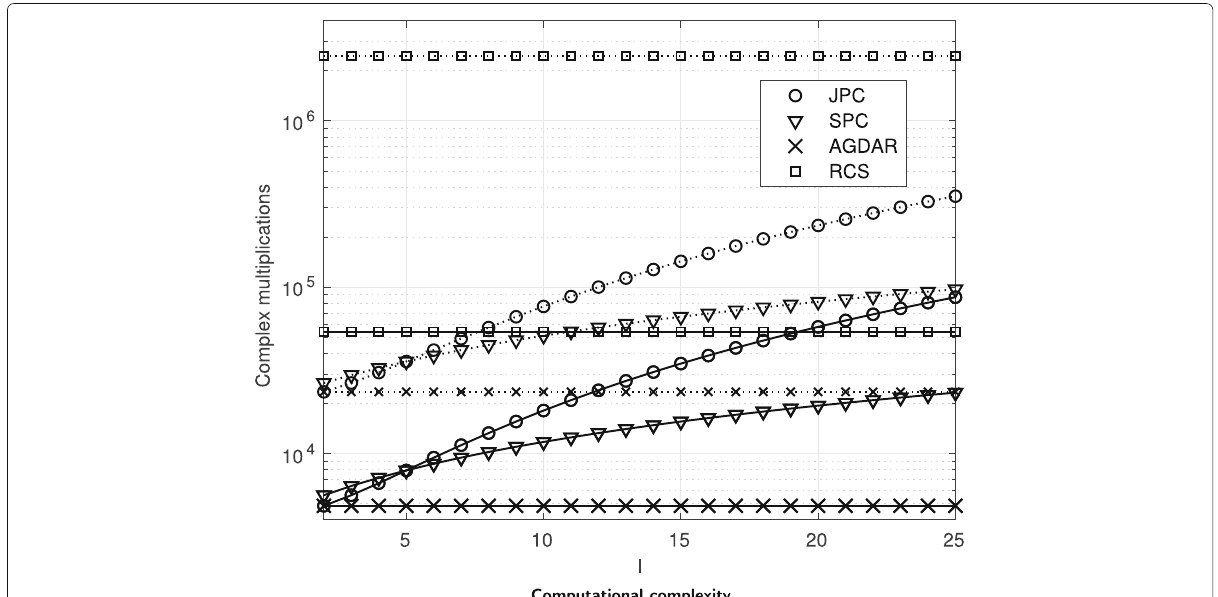
Fig. 13 Computational complexity. Average number of complex multiplications as function of I for various systems with ( M 1 = 32, M 2 = 4) (solid lines) and ( M 1 = 64, M 2 = 8) (dotted lines), ULA system with ( N r = 32, N t = 4) and SNR of 10 dB